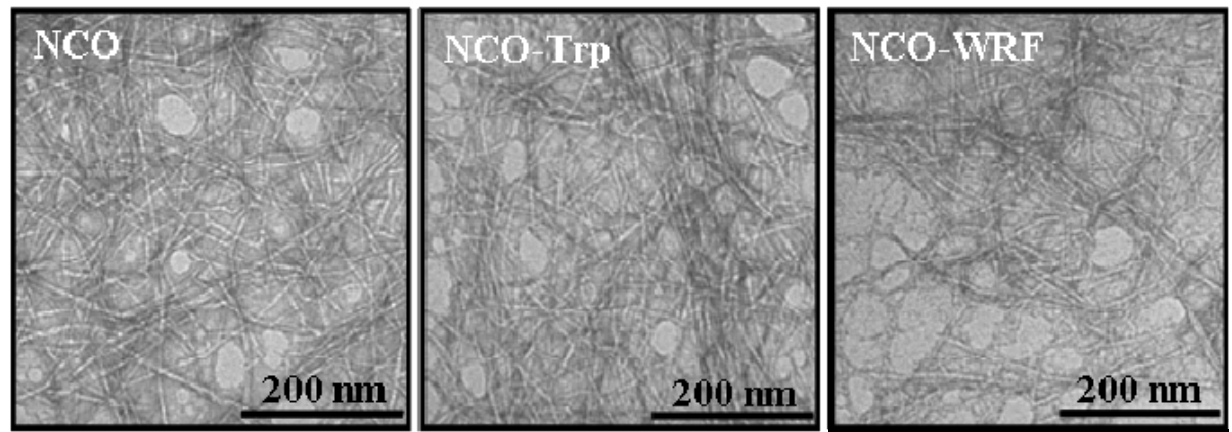
Figure 2. Transmission electron micrographs of ONC, ONC-Trp and